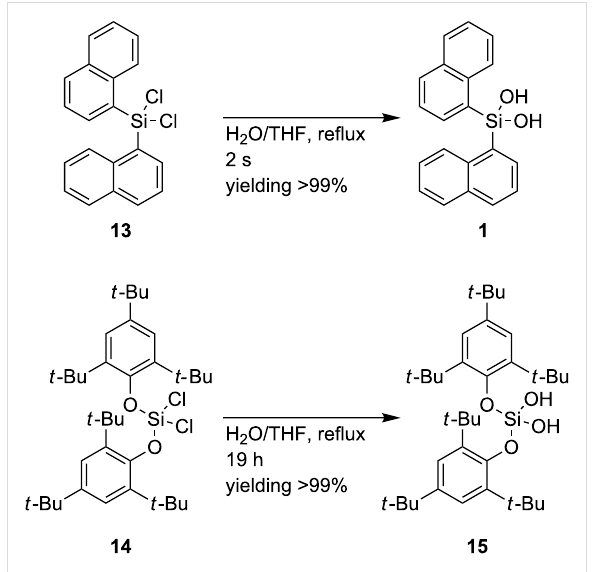
(Figure 2, red squares). The hydrolysis of dichlorosilanes 7 and 14 to the corresponding silanediols 9 (Scheme 3) and 15 (Scheme 4) is investigated further (Figure 2). The conversion